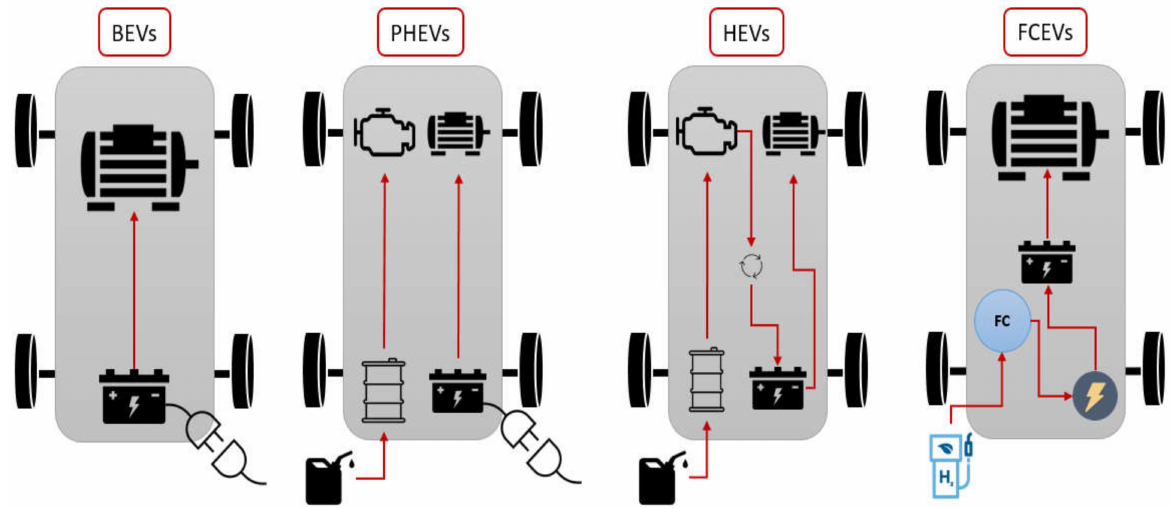
Figure 3. Types of electric vehicles and configuration of the